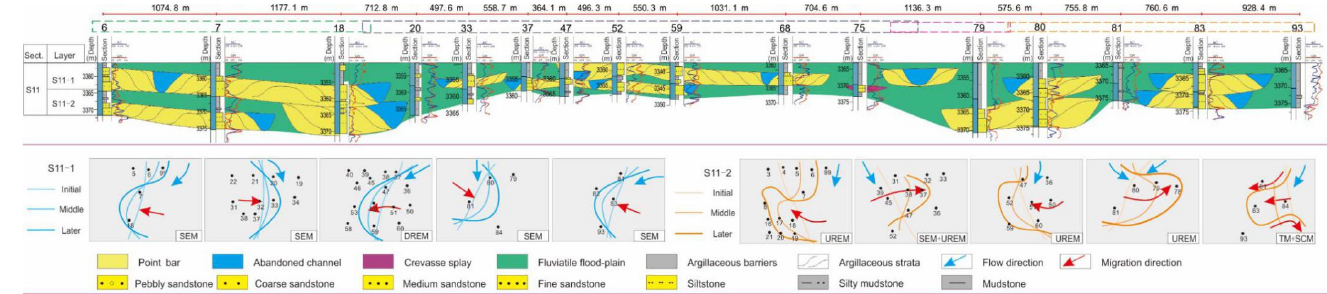
Figure 14. Profile L5 of comprehensive analysis including evolution model of meander bend-based multiple connected core wells which are collected from database in S 11 sublayer of Su-X block, Sulige gas field, Ordos Basin, China: migration areas Z1 (green frame), Z4 (gray frame), Z6 (orange frame).